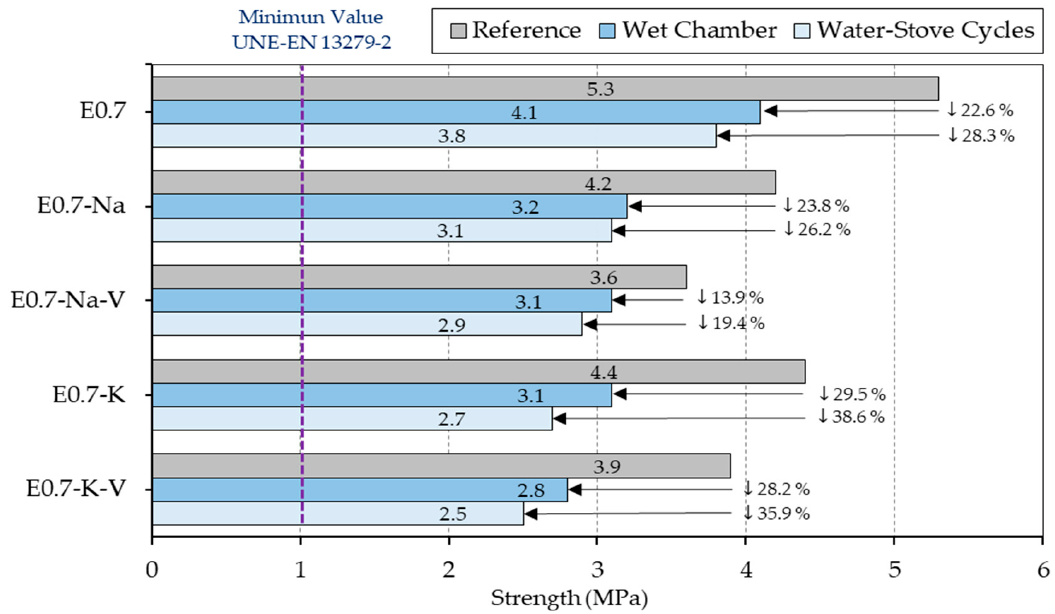
Figure 6. Flexural strength test results compared.